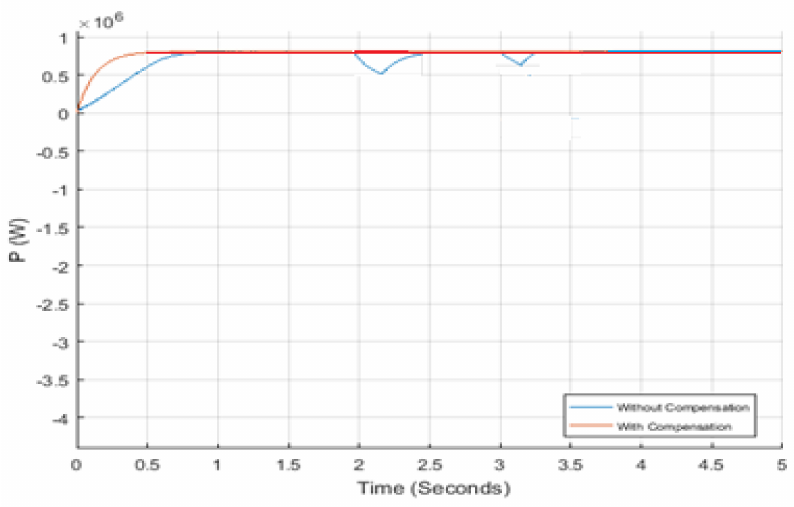
Figure 23. Active power with and without compensation for a wind speed 7 m/s and irradiance 400 W/m 2 .